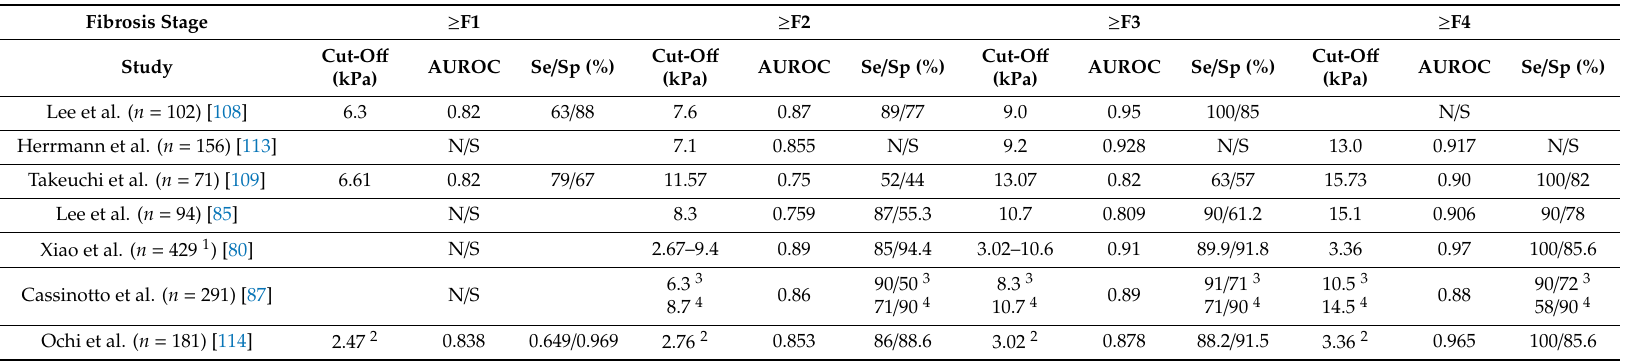
Table 4. Performance of LSM was assessed by 2D-SWE for detecting di ff erent stages of liver fibrosis in patients with